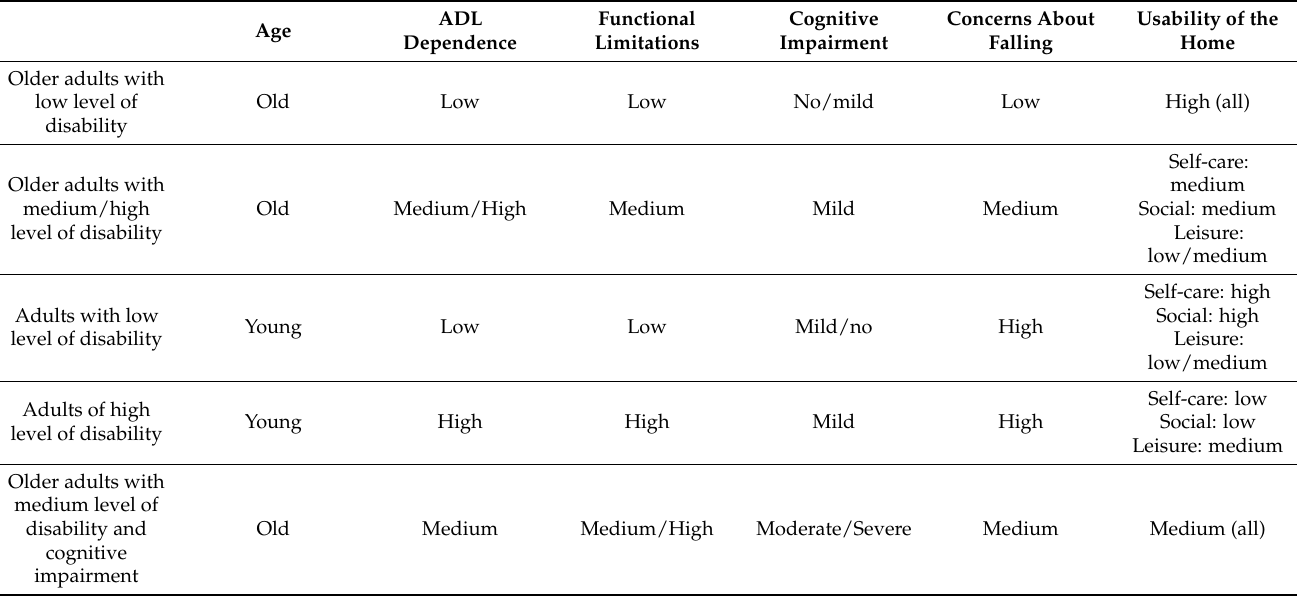
Table 1. Characteristics of the five client profiles.